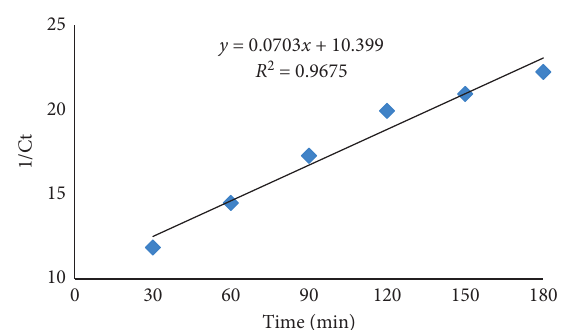
Figure 9: The second-order reaction rate in TMP photo- degradation oxidation process.